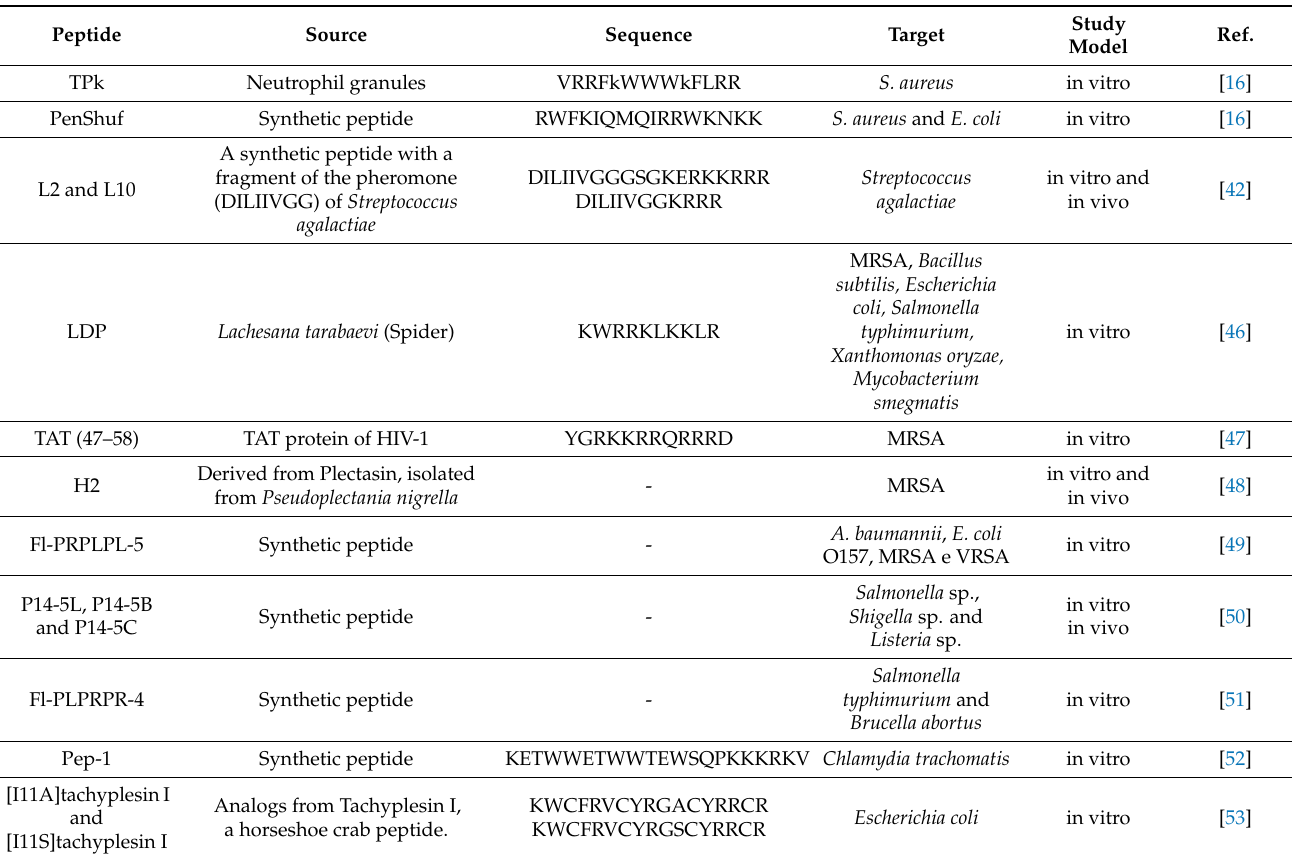
Table 1. CPAPs with anti-infective activity against intracellular